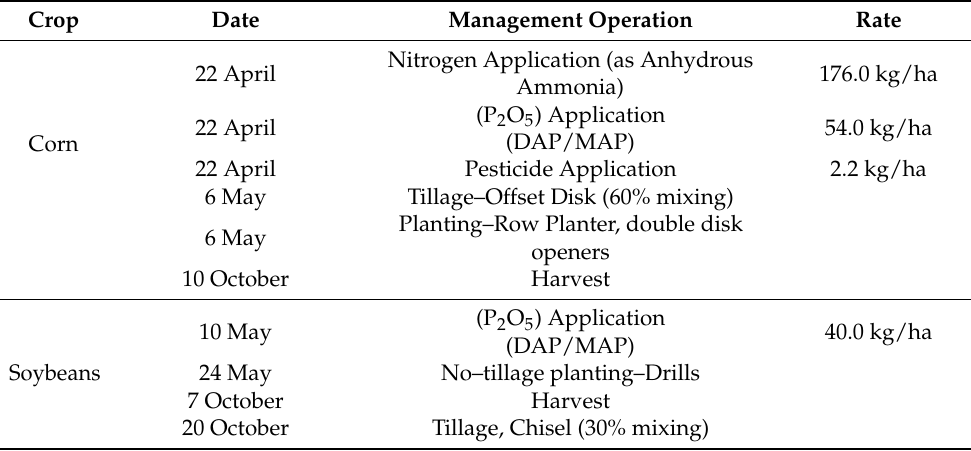
Table 2. Agronomic practices or management operations for different land use/ land cover for the Matson Ditch Watershed [11,49].